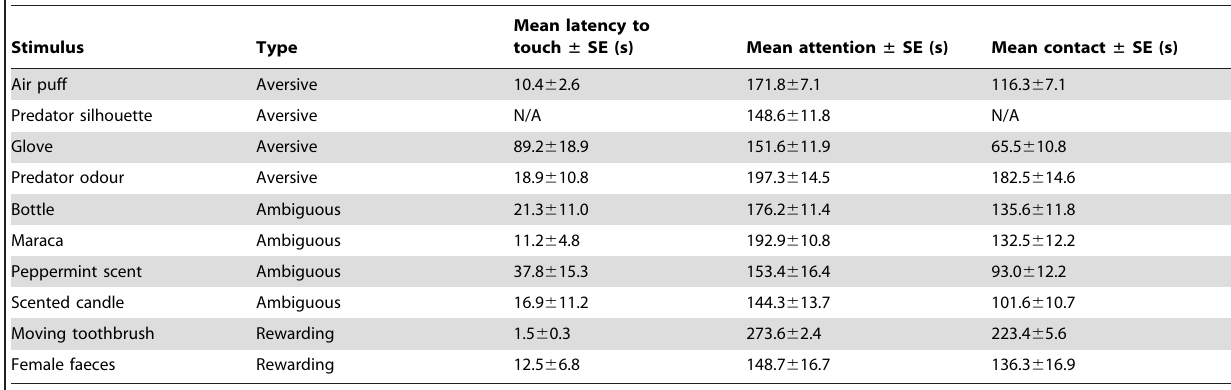
Table 3. Investigatory behaviour tests.